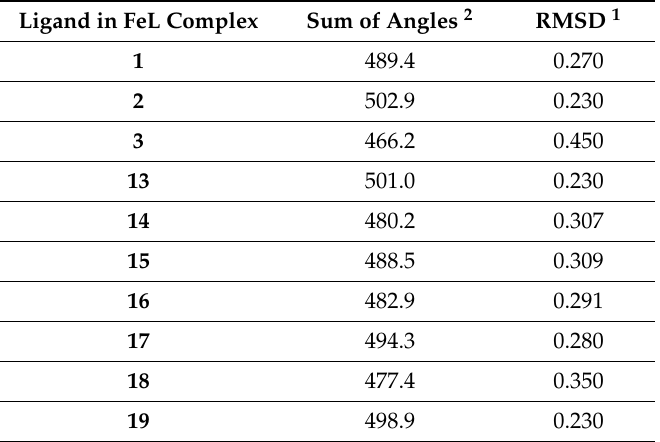
Table 2. Hypothetical catechol siderophore